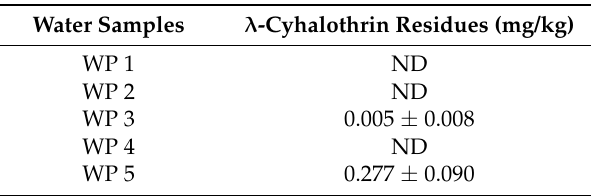
Table 2. Level of λ -cyhalothrin residues in water samples collected from mapped water bodies identified at the vegetable farm of Houeyiho. Water